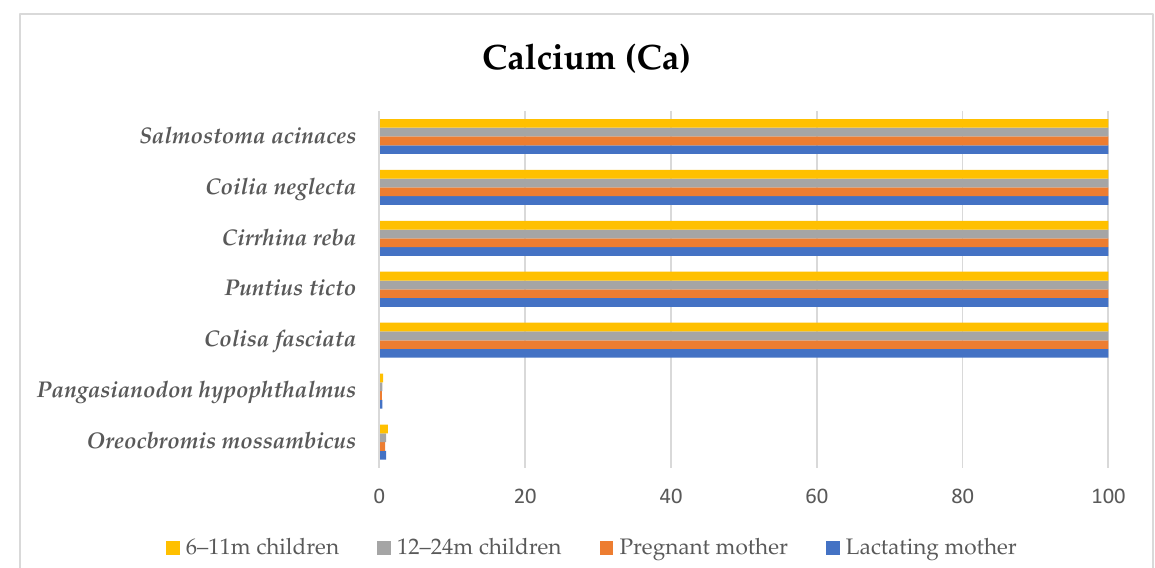
Figure 5. Potential contribution (%) of dry fish to the RNI of calcium for lactating and pregnant women and children in Bangladesh. Local names: Chela ( Salmostoma acinaces ), Olua ( Coilia neglecta ), Bata ( Cirrhina reba ), Punti ( Puntius ticto ), Khailsa ( Colisa fasciata ), Thai Pangas ( Pangasianodon hypophthalmus ), and Tilapia ( Oreocbromis mossambicus